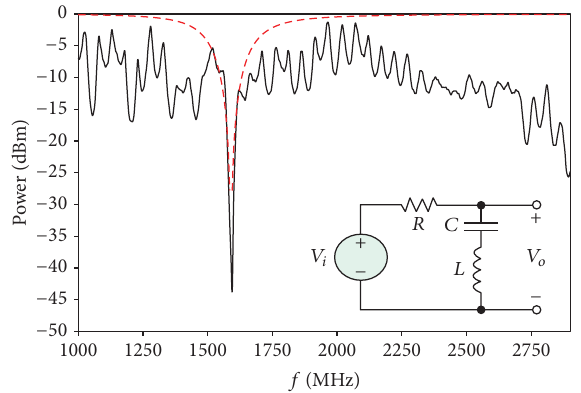
Figure 5: Gain-frequency dependence of the Au/BN/C device. Dashed plot is the transfer function of the modeled RLC